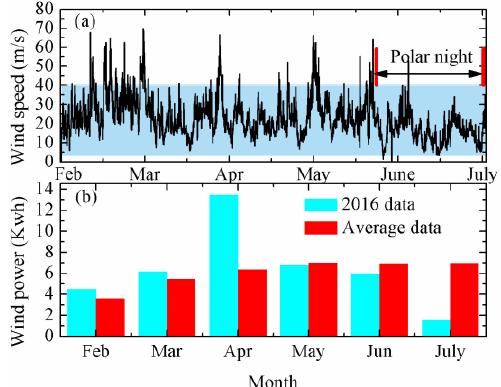
Figure 21. Power voltage of the observing system. Area between the red lines is the polar